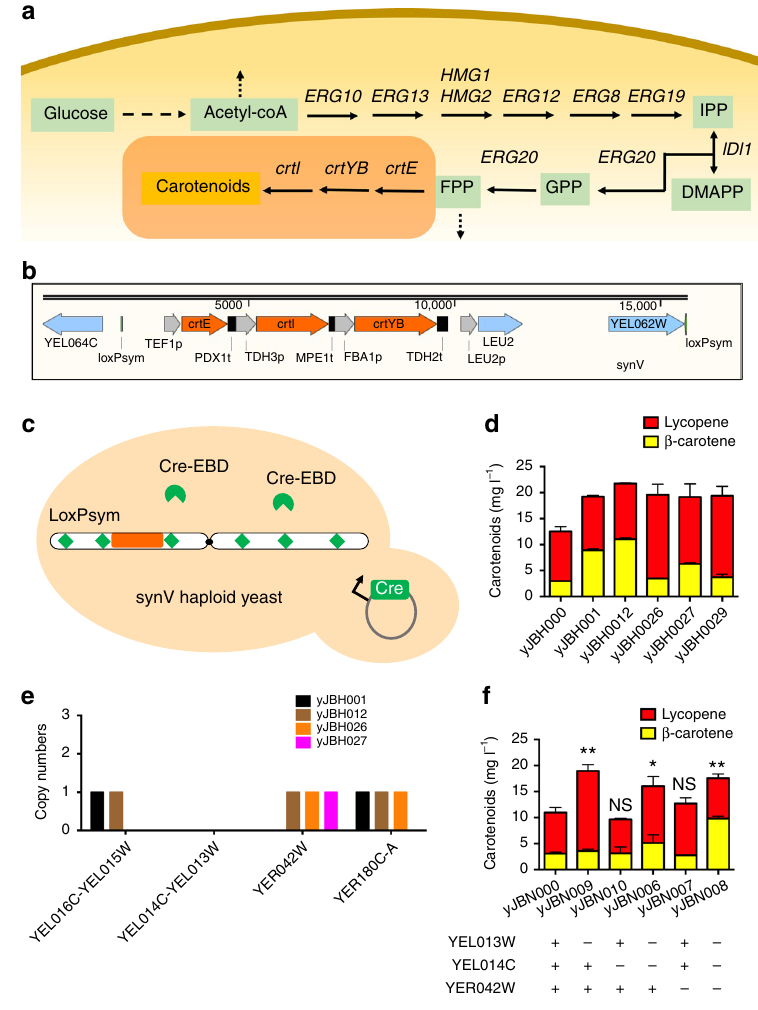
Fig. 2 SCRaMbLEing synV haploid yeast with integrated carotenoid pathway. a MVA pathway in yeast and the carotenoid synthesis pathway. b The carotenoid pathway was integrated into the YEL063C/CAN1 site of the synV yeast. c The synV haploid yeast cells containing pCRE4 were induced to SCRaMbLE. Single colonies were cultured in 5 ml of SC-His overnight and then re-inoculated to an OD600 of 1.0 in 2% galactose SGal-His medium containing 1 µ M estradiol for 8 h. d HPLC analysis of extracted carotenoids from cultures of fi ve selected strains. e Deep-sequencing analysis of yJBH001, yJBH012, yJBH026, and yJBH027. Deletions of YEL014C-YEL013W were observed in synV of all the four haploid strains. f Recon fi rmation of genome structural variation. yJBN000 is the control. yJBN006 is the YEL014C-YEL013W deletion of yJBH000. yJBN007 is the YER042W deletion of yJBH000. yJBN008 is the double deletion of YEL014C-YEL013W and YER042W in yJBH000. (Student ’ s t -test; NS, not signi fi cant; * P < 0.05, ** P < 0.001). In d , f , error bars represent SD from three independent